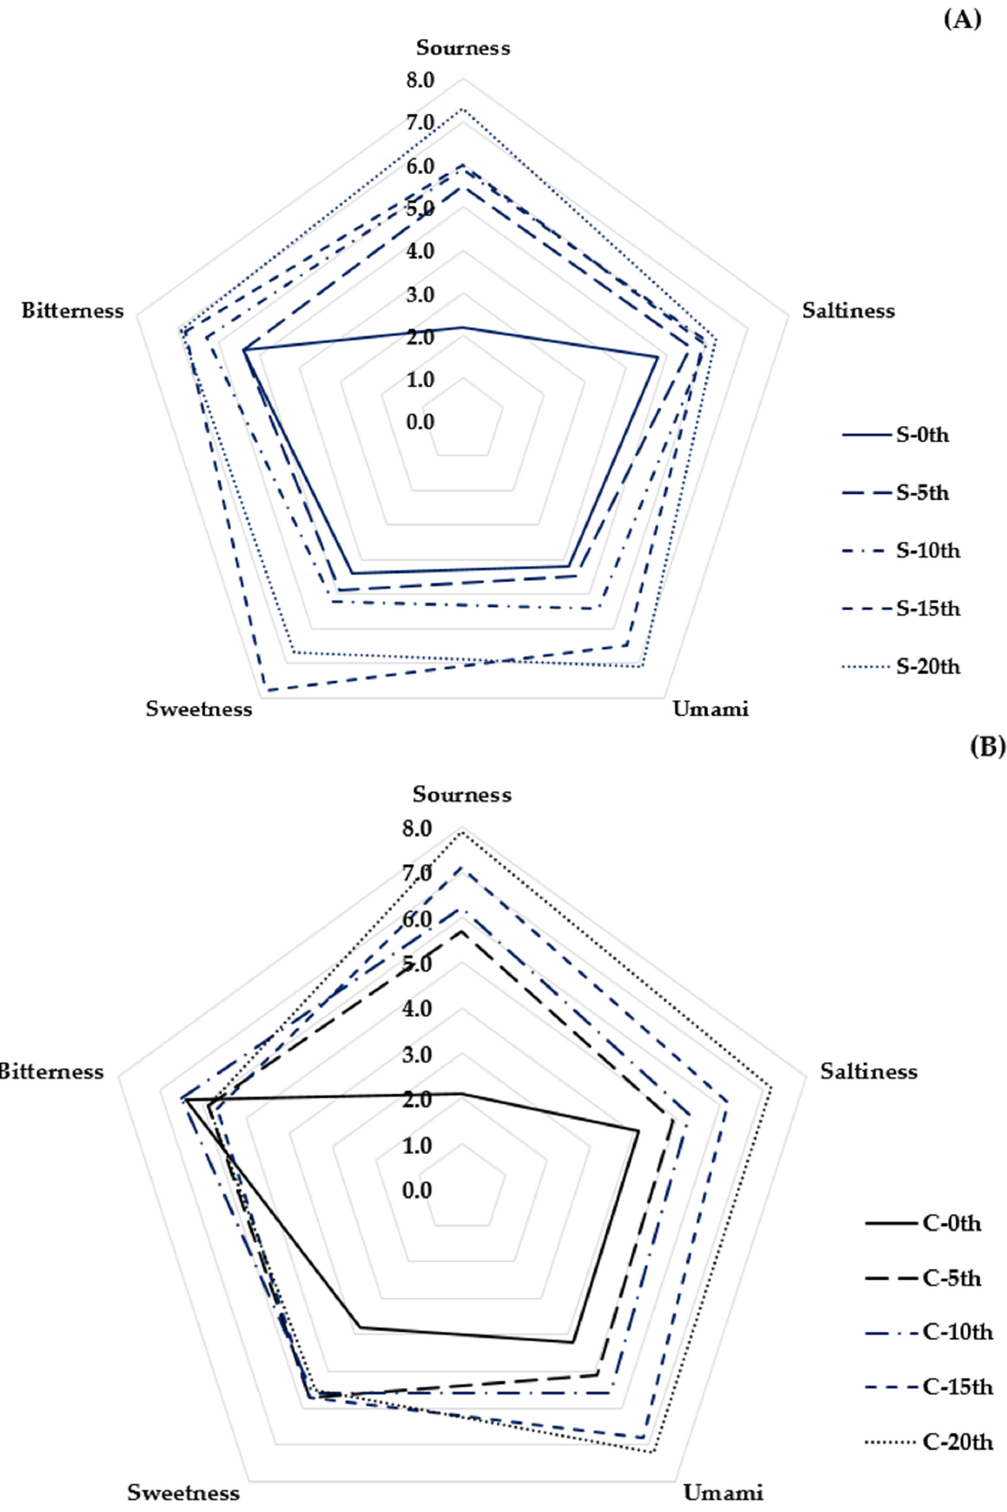
Figure 1. ( A ) Five basic tastes of repetitively fried soybean oil analyzed by electronic tongue. ( B ) Five basic tastes of repetitively fried canola oil analyzed by electronic tongue.